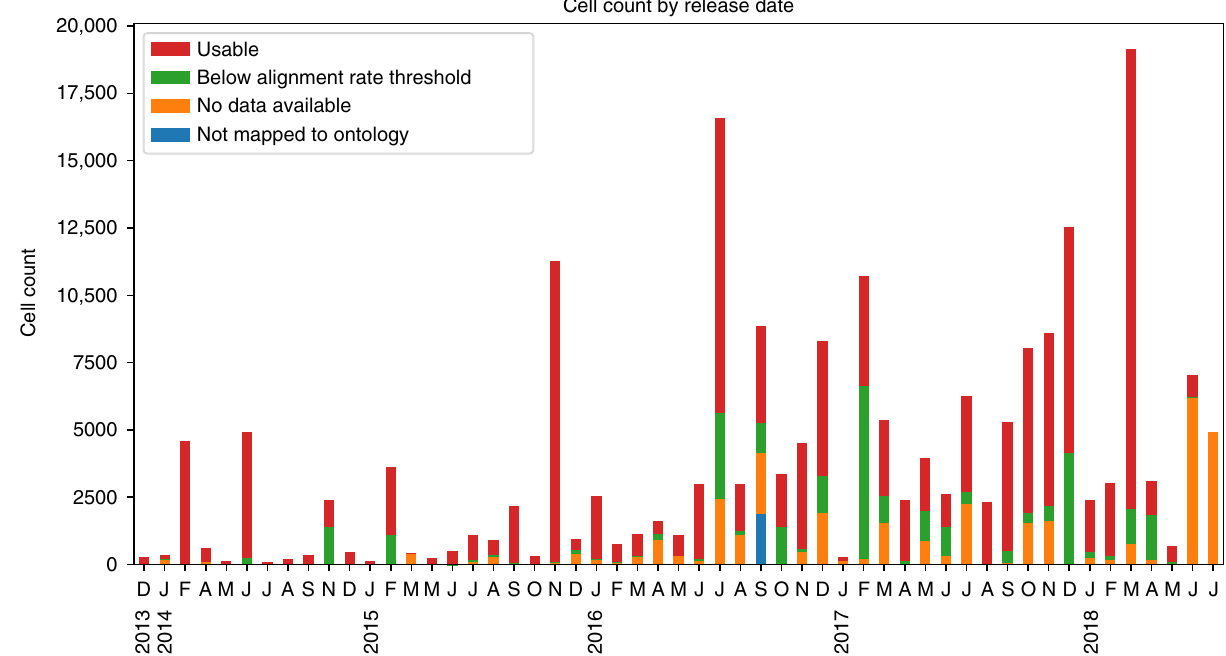
Fig. 2 Monthly cell count available on GEO and ArrayExpress. Cell counts by month, separated into four categories: usable, below our alignment rate threshold, no raw or author-processed data available, and unmapped to ontology terms